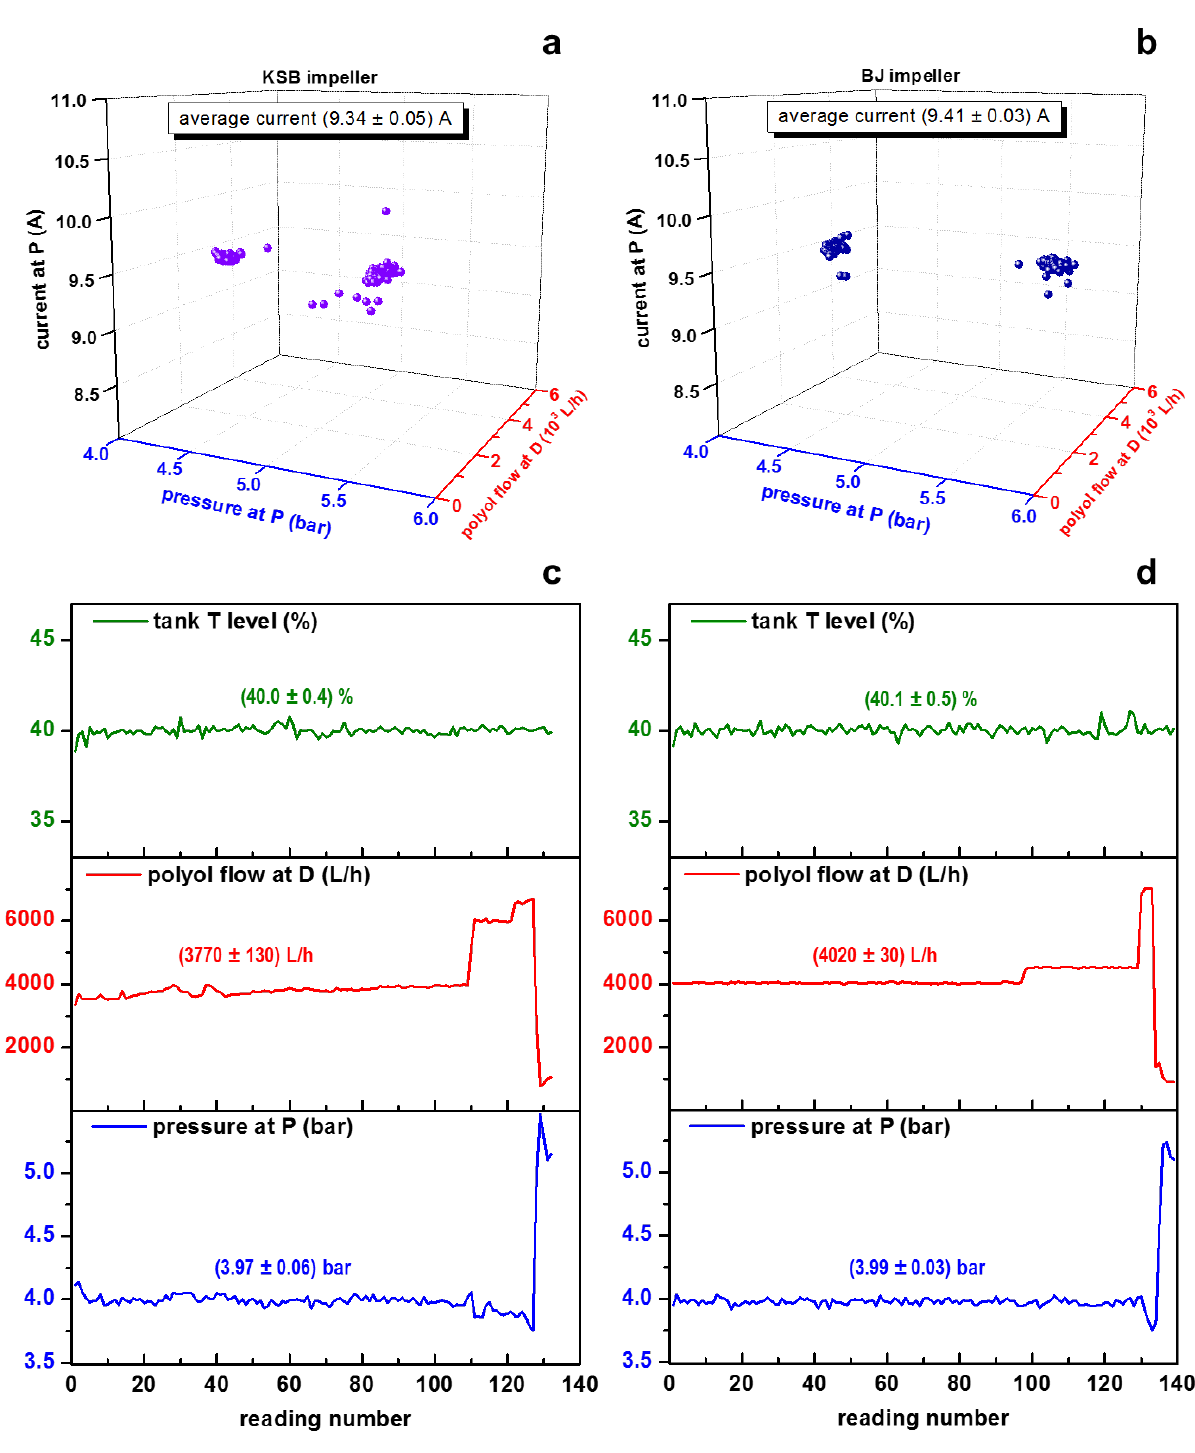
Figure 11. Recipe 1 . ( a , b ) Dependence of pump amperage (current) on pump pressure and polyol flow for two consecutive production cycles. ( c , d ) Tank level, polyol flow, and pump pressure, read continuously for a complete production cycle. KSB impeller ( a , c ), BJ impeller ( b , d ).